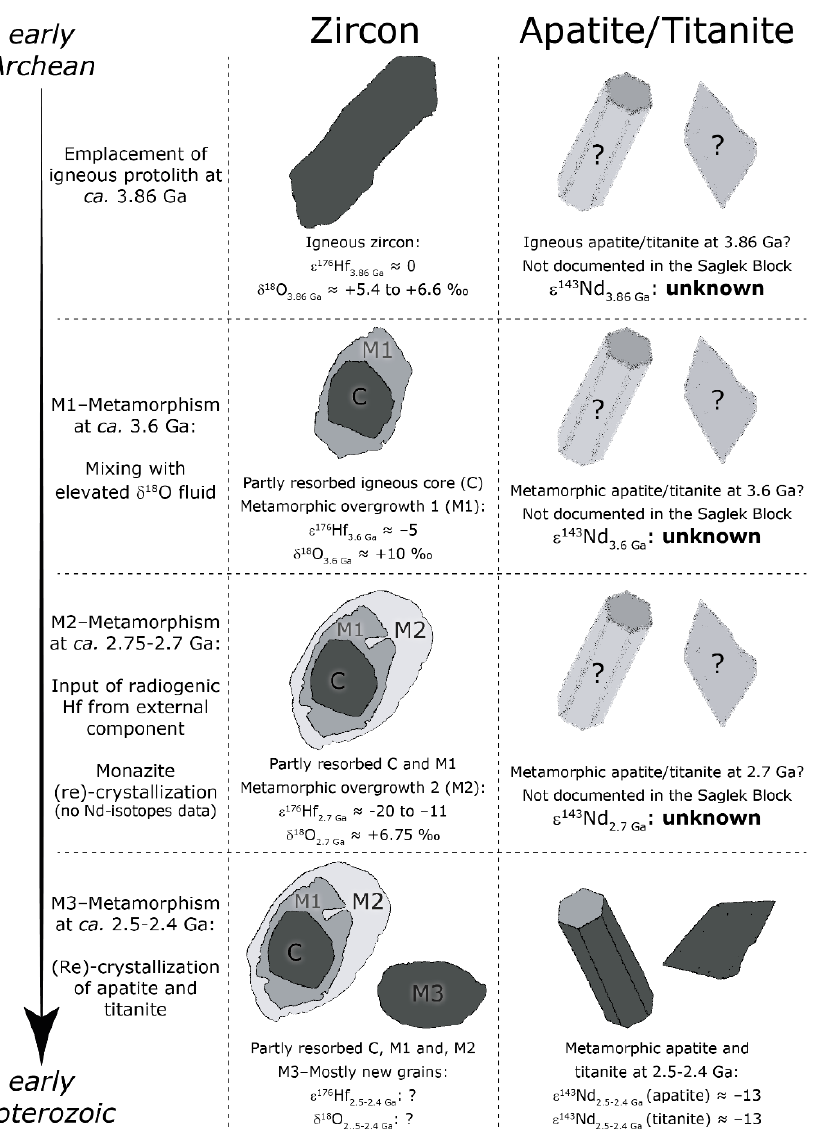
Figure 7. Evolution of Hf- and Nd-isotopes compositions of zircon and REE-rich minerals throughout the metamorphic history of the Archean Saglek Block.